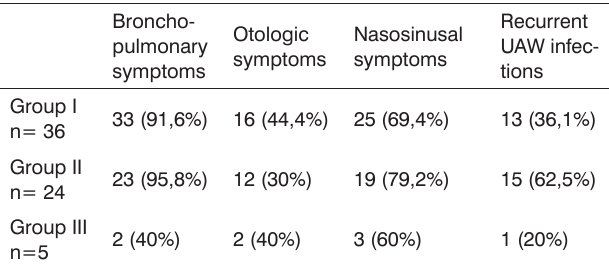
Table 2. Symptom prevalence according to study group.s